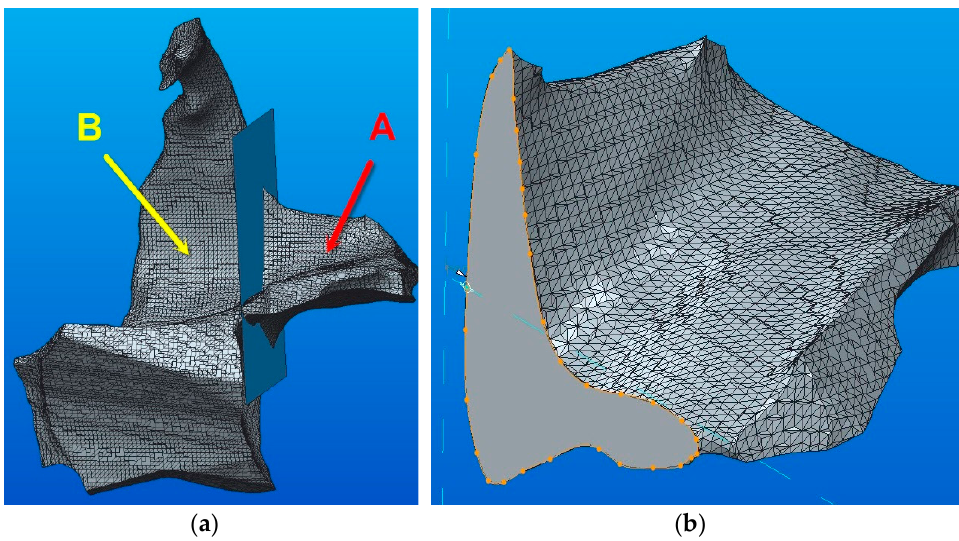
Figure 10. The conversion of the 3D model (STL type) of the zygomatic bone: ( a ) 3D model compo- nents; ( b ) the bonding section.